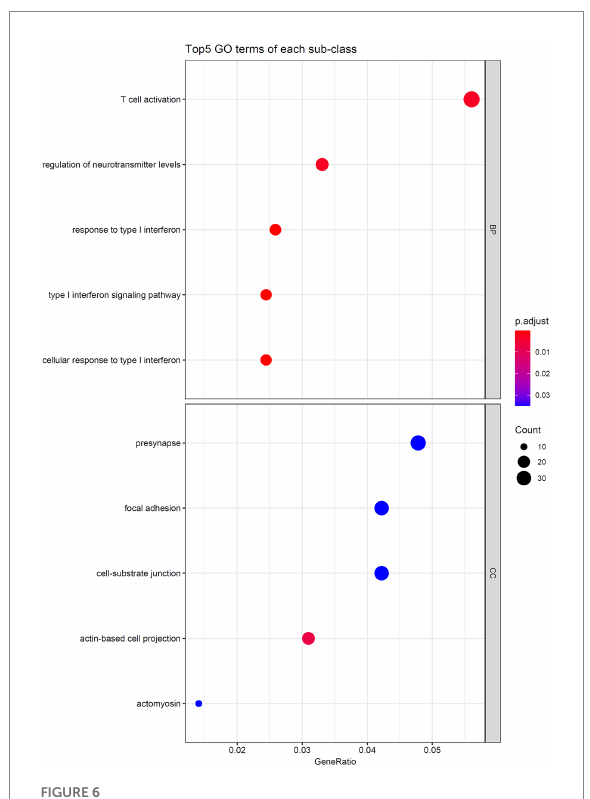
FIGURE 7 Top five KEGG pathways enriched by the genes converted by the top 1,025 methylation